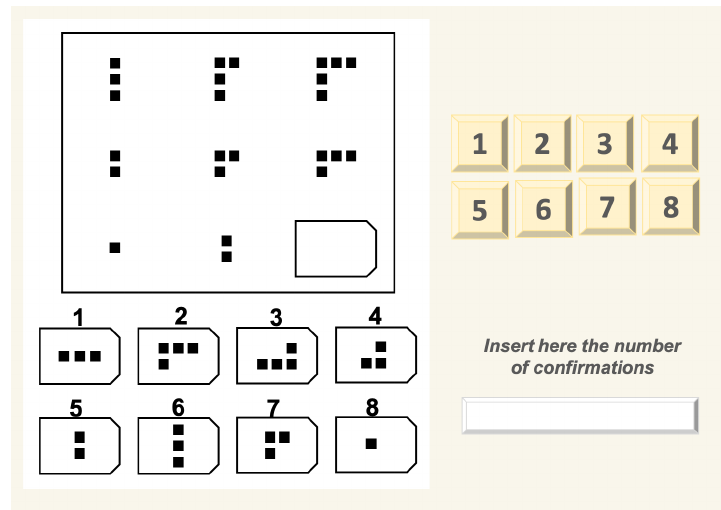
Figure 3. Users’ interface for the task in face-to-face (FTF) condition. The user interface of the panel used by researchers to save the data during experimental sessions of face-to-face groups (translated in English from Italian). Buttons 1–8 correspond to the eight answers options for the matrix, and the space under the buttons was used to take note of the number of members who agreed with the given